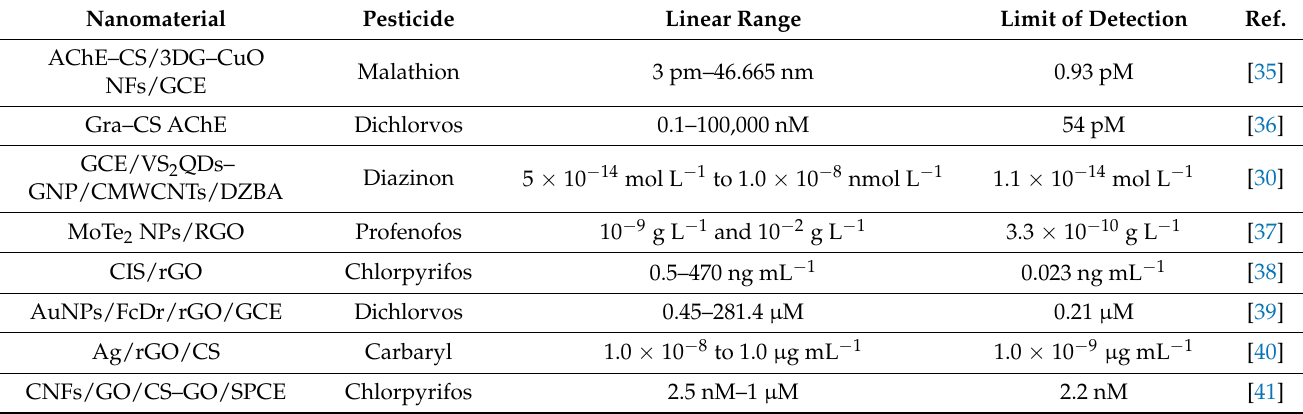
Table 1. Electrochemical sensing of pesticides using GO/rGO-based